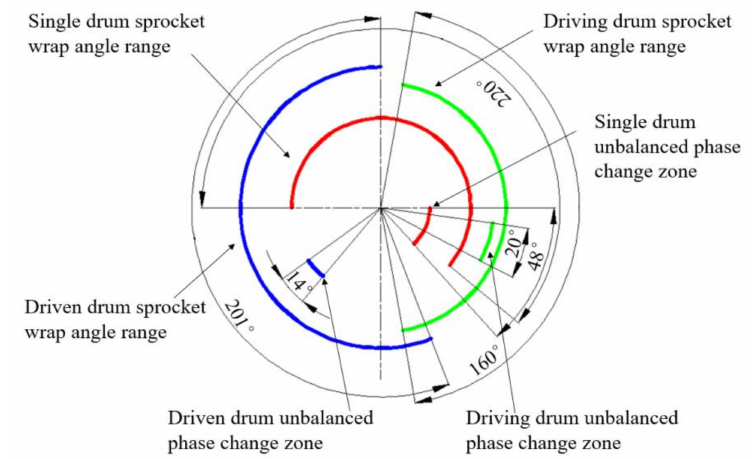
Figure 10. Threshing drum unbalanced phase change